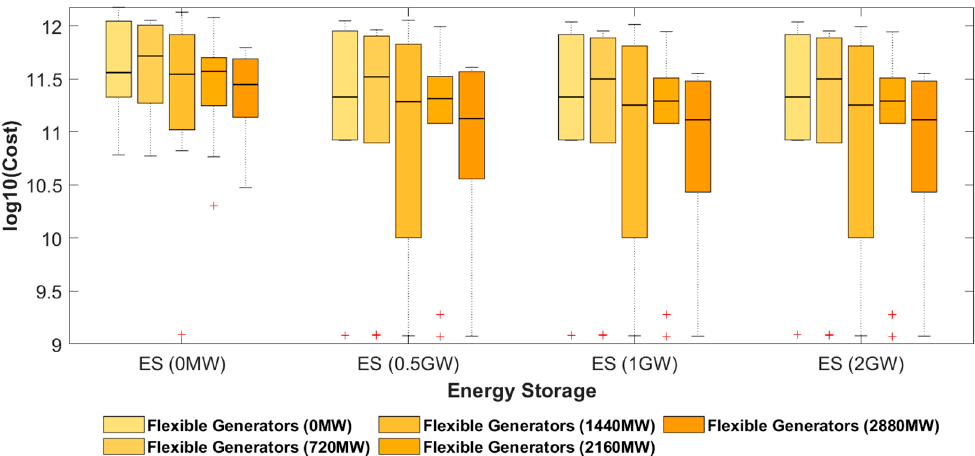
Figure 10. Cost comparison of multi-scenario unit scheduling in summer.